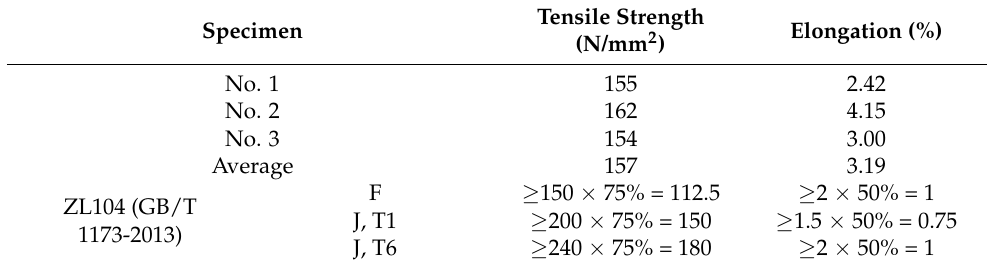
Table 1. Tensile test results of manhole cover base.